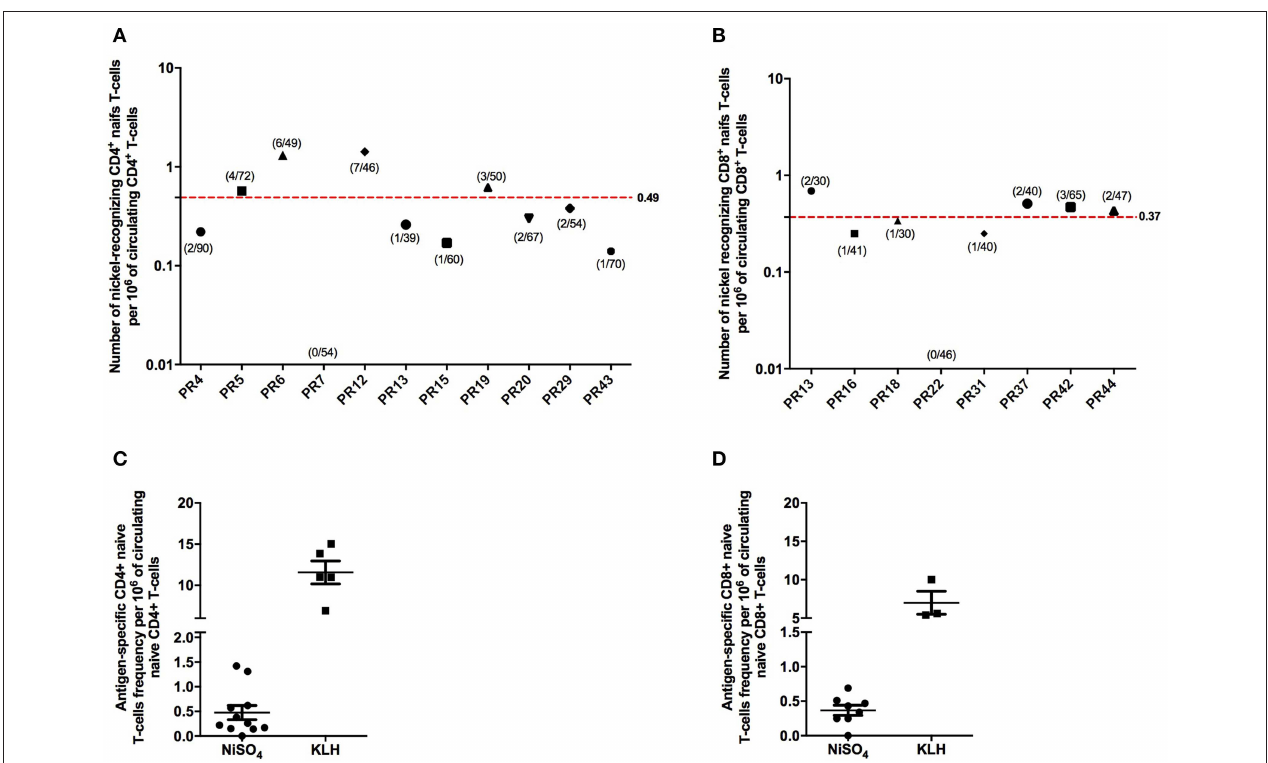
FIGURE 2 | Frequency of human naive CD4 + and CD8 + T cells recognizing nickel. Frequency of human naïve CD4 + (A) and CD8 + (B) T cells specific to nickel. Frequency was calculated for each donor using the Poisson distribution law. On the x-axis is represented the donor’s number. For the different donors tested, the number of T-cell lines found specific for nickel out of the number of T-cell lines tested is indicated in brackets. (C,D) Comparison of the nickel-specific T-cell frequency to the KLH-specific T-cell frequency measured on different donors.